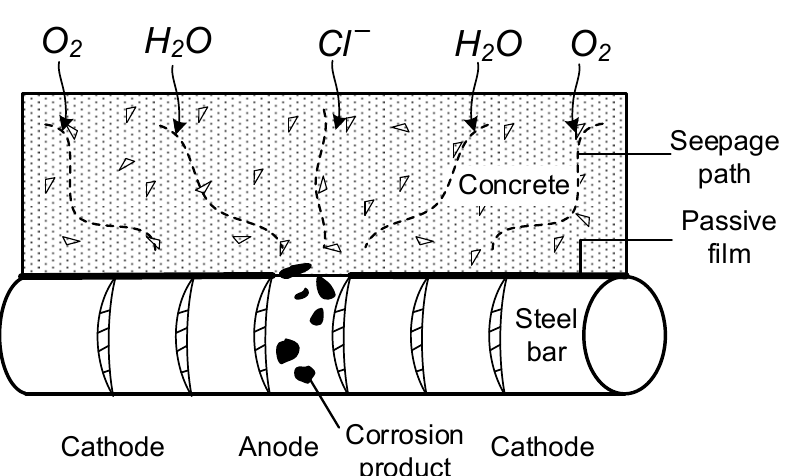
Figure 4. The schematic diagram of electrochemical principle. Adapted with permission from [29].